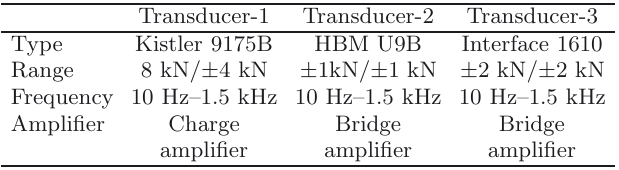
Table 1. List of chosen force transducers.